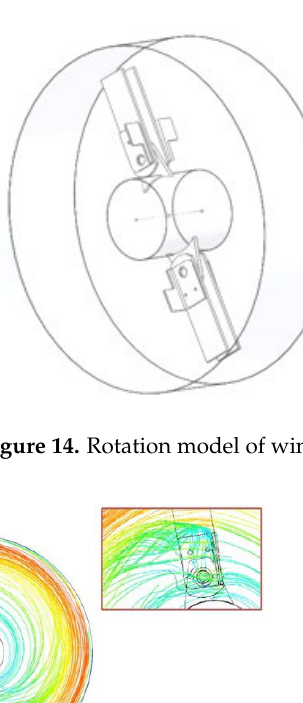
Figure 13. Installation form of wind blades. ( a ) Forward installation; ( b ) reverse installation.